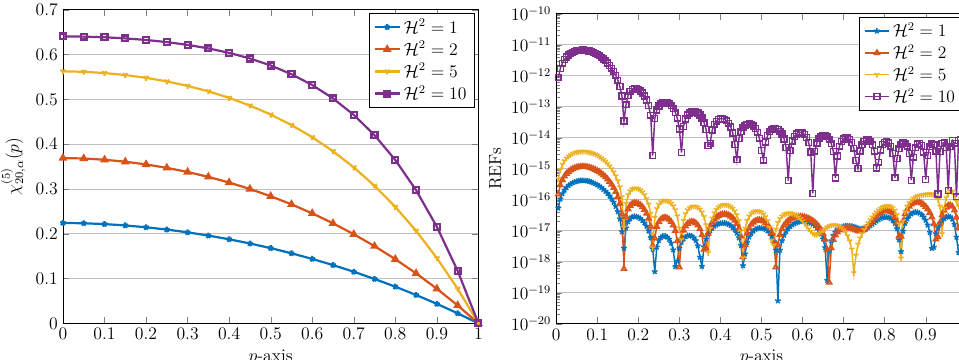
Figure 6. Graphics of numerical solutions obtained via the QLM-GSAPSK technique ( left ) and related REFs ( right ) with R = 20, α = θ , δ = 0.5, and with fractional-orders θ = 1.9, λ = 0.9. Table 4. A comparison of numerical outcomes/REFs in QLM-GSAPSK with θ = 1.9, λ = 0.9,